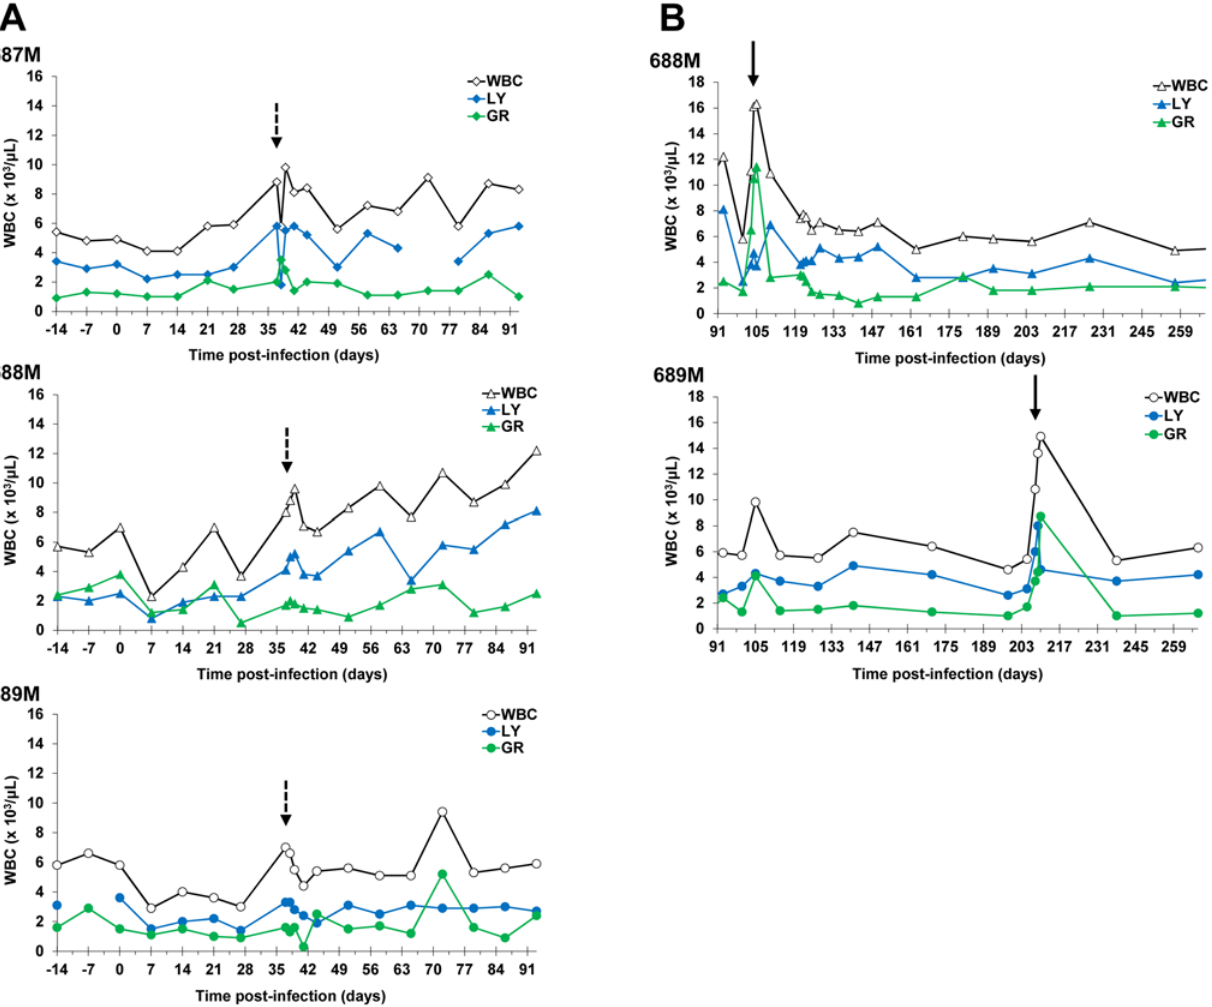
Fig 7. White cell changes in the blood of three infected monkeys treated with the diamidine prodrug DB868. DB868 was administered orally at 20 mg/kg/day (689M), 10 mg/kg/day (688M), or 3 mg/kg/day (687M) for 10 days after infection with T. b. rhodesiense KETRI 2537 (28 – 37 days post- infection). Confirmed relapses were rescue-treated with melarsoprol intravenously at 3.6 mg/kg/day for 4 consecutive days. White blood cell changes from ( A ) -14 to 93 days and ( B ) 93 to 268 days post-infection. M, male; WBC, white blood cells; LY, lymphocytes; GR, granulocytes. Dashed arrows, last DB868 dose; bold arrows, last melarsoprol